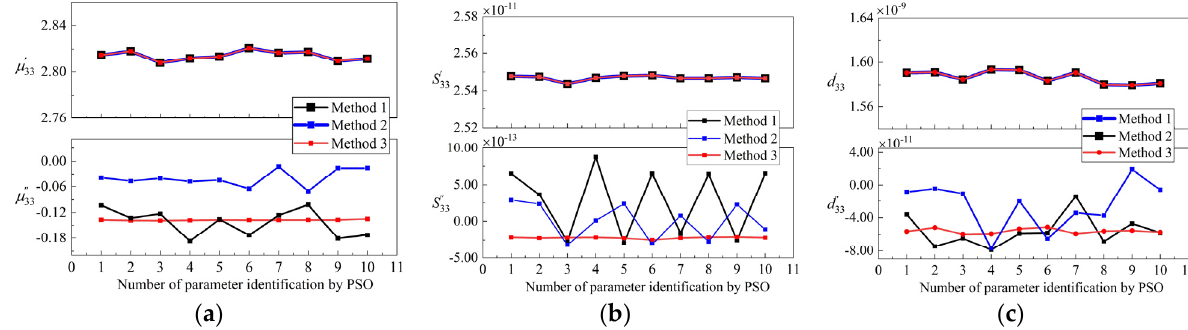
Figure 14. Comparison of the results of ten extractions with the three different methods at 10 Mpa ( a ) µ 33’ and µ 33’’ ; ( b ) S 33’ and S 33’’ ; ( c ) d 33’ and d 33’’ .